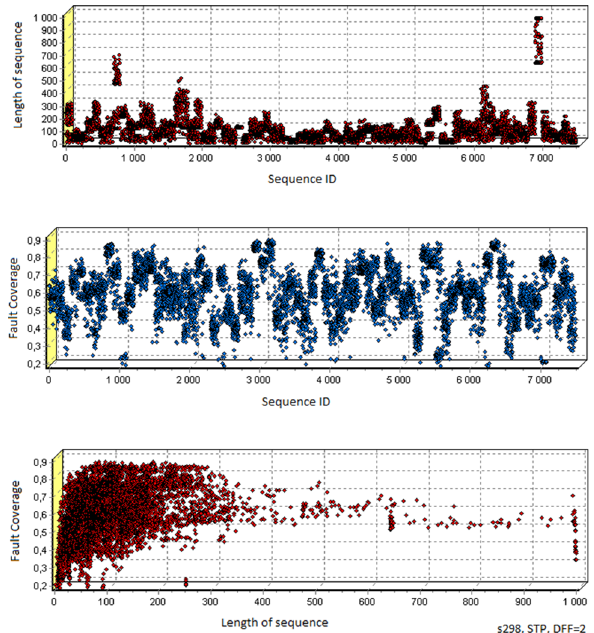
Fig. 23 STP for s298 with use of 2 internal flip-flops